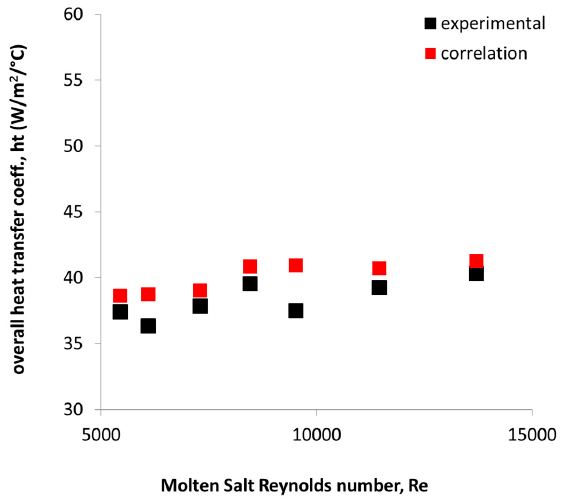
Figure 10. Comparison between experimental (black points) and theoretical (red points) values obtained for the overall heat transfer coefficient in the MSH prototype using the Hitec XL ® molten salt as HTF under different MS Reynolds. Inlet “hot” gas at 612 (±12) °C.